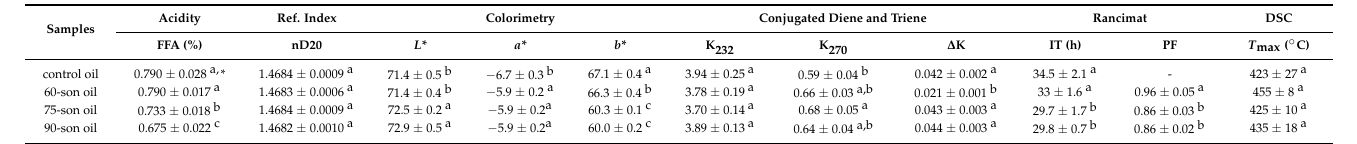
Table 2. Physicochemical parameters of enriched olive